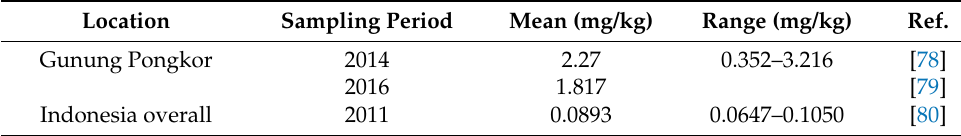
Table 5. Total arsenic concentration in rice samples in